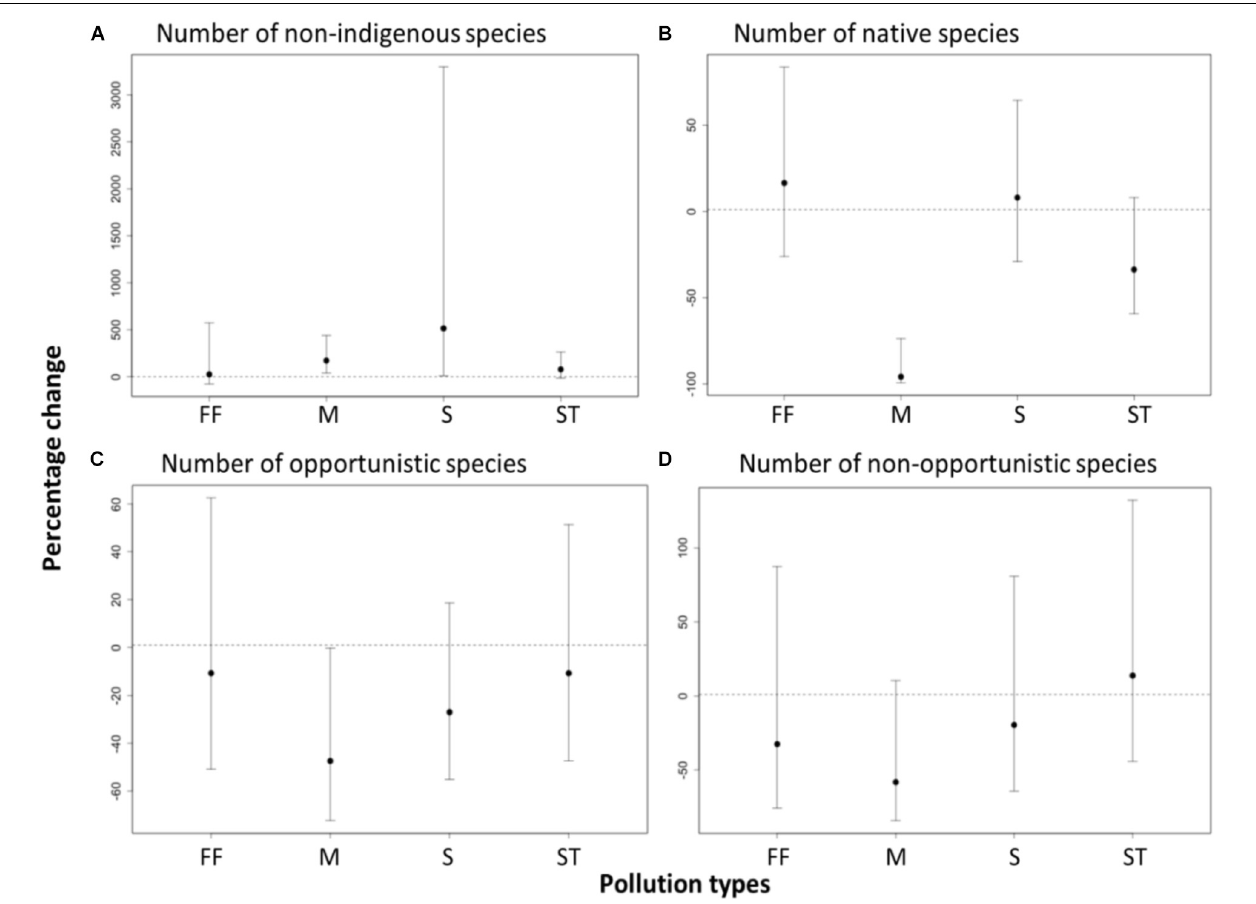
FIGURE 3 | Effects of pollution from anthropogenic point sources [fish farms (FF), marinas (M), sewage outfalls (S), and stormwater drains (ST)] on the percentage change in the number of recruited (A) non-indigenous, (B) native, (C) opportunistic and (D) non-opportunistic species. Effects are significant if confidence intervals do not overlap zero. Percentage change was calculated from GLMM estimates based on a quasi-poisson, mixed effect model with a log